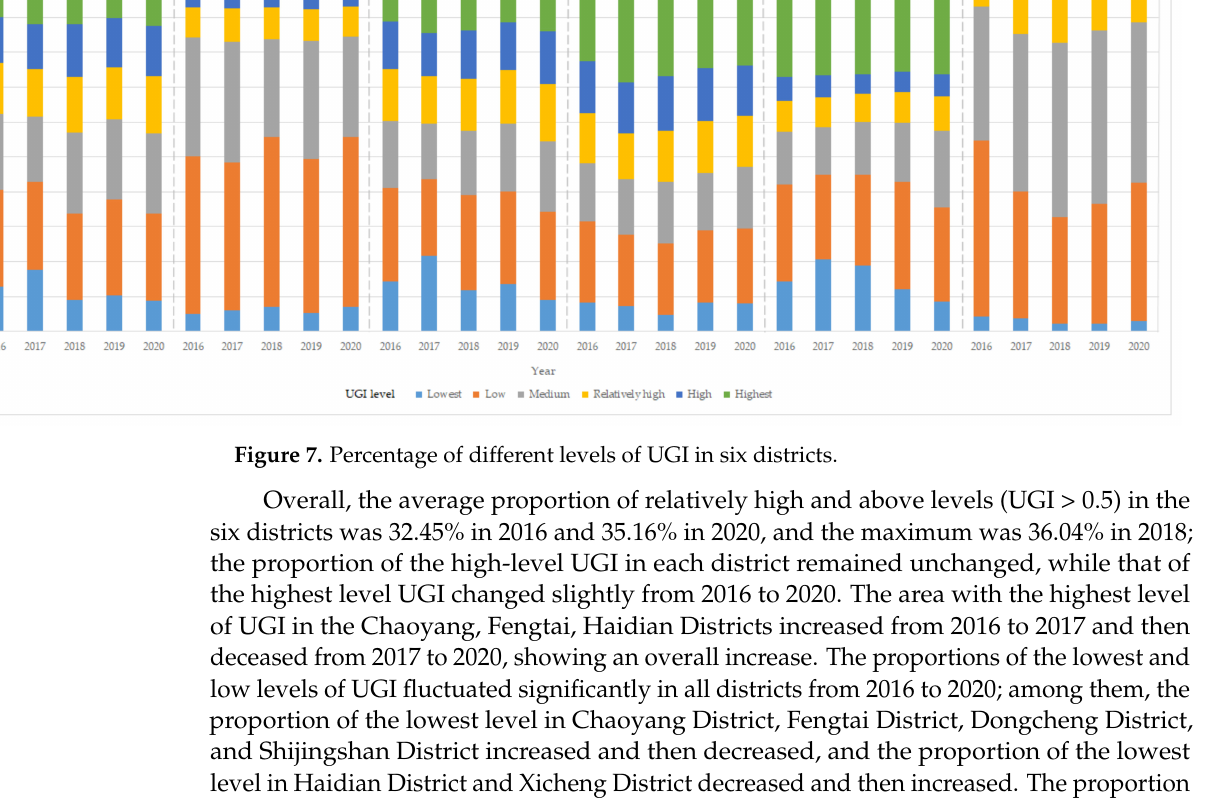
3.3. Annual Dynamic Evaluation of the Quality of UGS by Using UGI and SHDI at Pixel Level